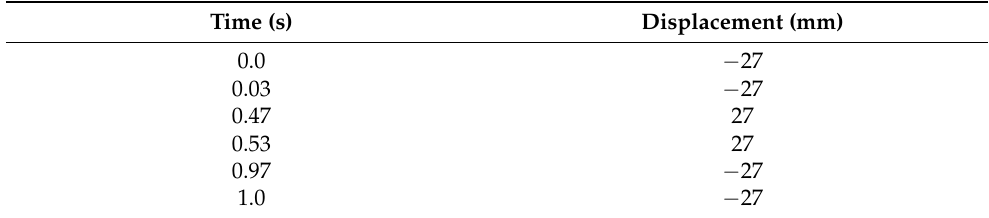
of counter surface. of counter